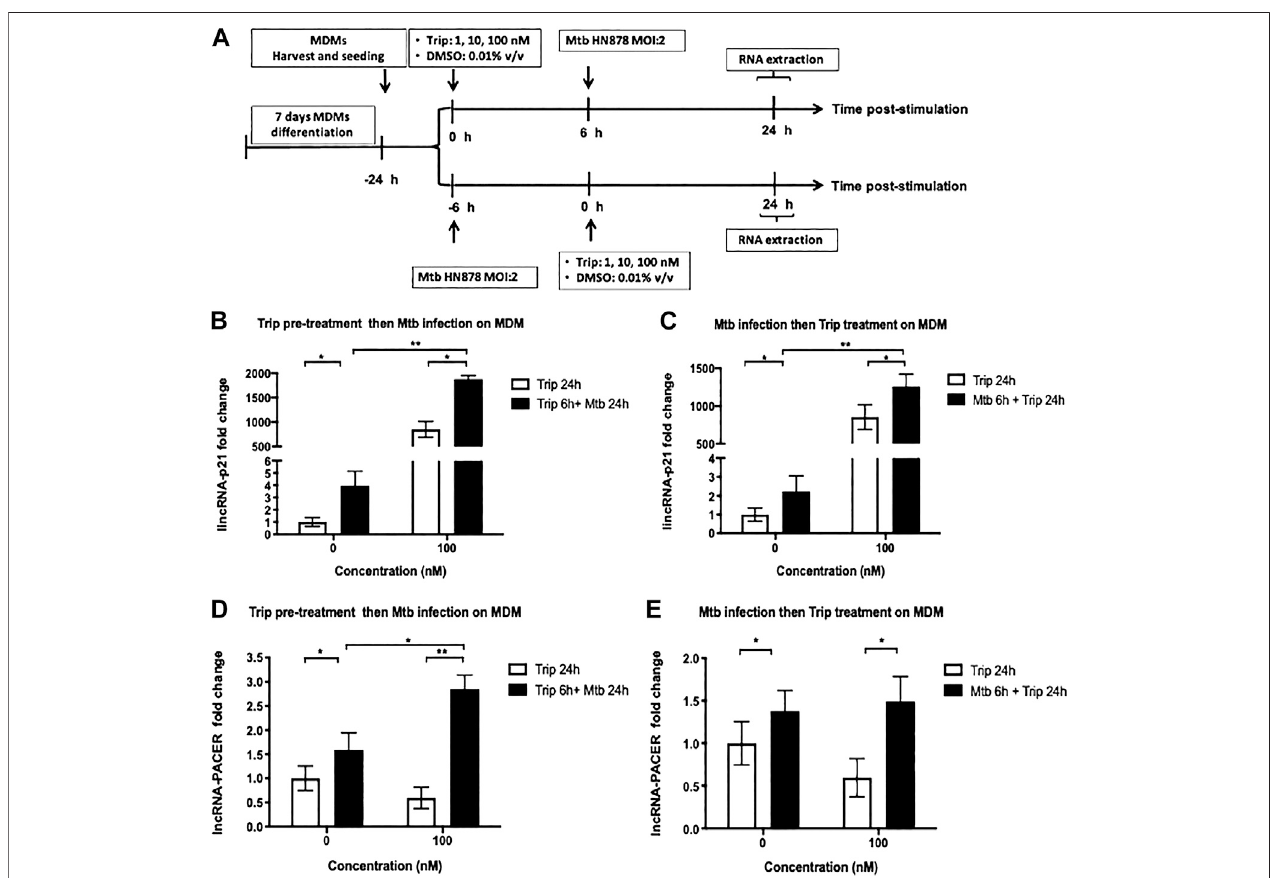
FIGURE 3 | Triptolide pretreatment or posttreatment further increases Mtb HN878-induced expression oflincRNA-P21and lncRNA-PACER inMDMs. (A) : Graphical summaryfortheexperimentsonMtbHN878infectionofMDMspre-andpost-triptolidetreatments.Triptolidepretreatment (B,D) :MDMswerepretreatedwiththeindicated concentrationsoftriptolidefor6 htheninfectedwithMtbHN878MOI:2upto24 h.DMSOwasusedasavectorcontrol.TotalRNAwasextractedandthenlincRNA-p21 (B) and lncRNA-PACER (D) expression levels were assessed by RT-qPCR. Triptolide post-treatment (C, E) : MDMs were infected with Mtb HN878 MOI:2 for 6 h then treated with the indicated concentrations of triptolide up to 24 h. DMSO was used as a vector control. Total RNA was extracted, and then lincRNA p-21 (C) and lncRNA- PACER (E) expression levels were assessed by RT-qPCR. Relative expression was calculated using the − ΔΔ Ct method. * p < 0.05; ** p < 0.01; *** p < 0.001.